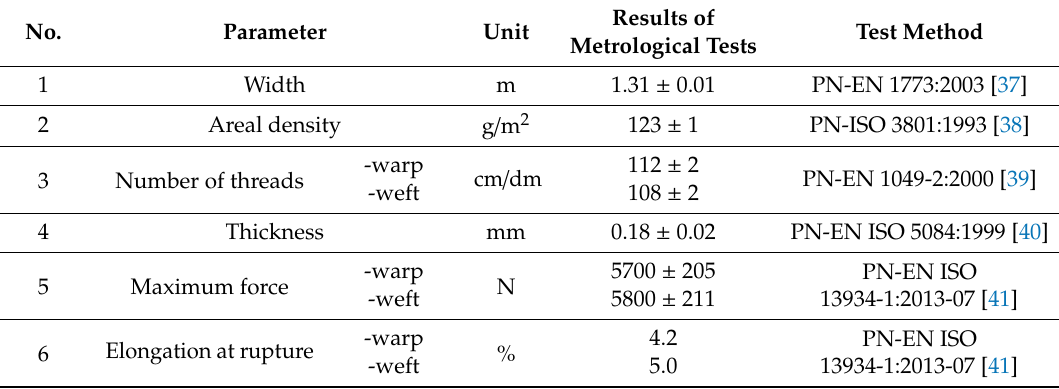
Table 4. Physical and mechanical parameters of the Poron ® XRDMA (Polting Foam Sp. zo.o, Gliwice, Poland).